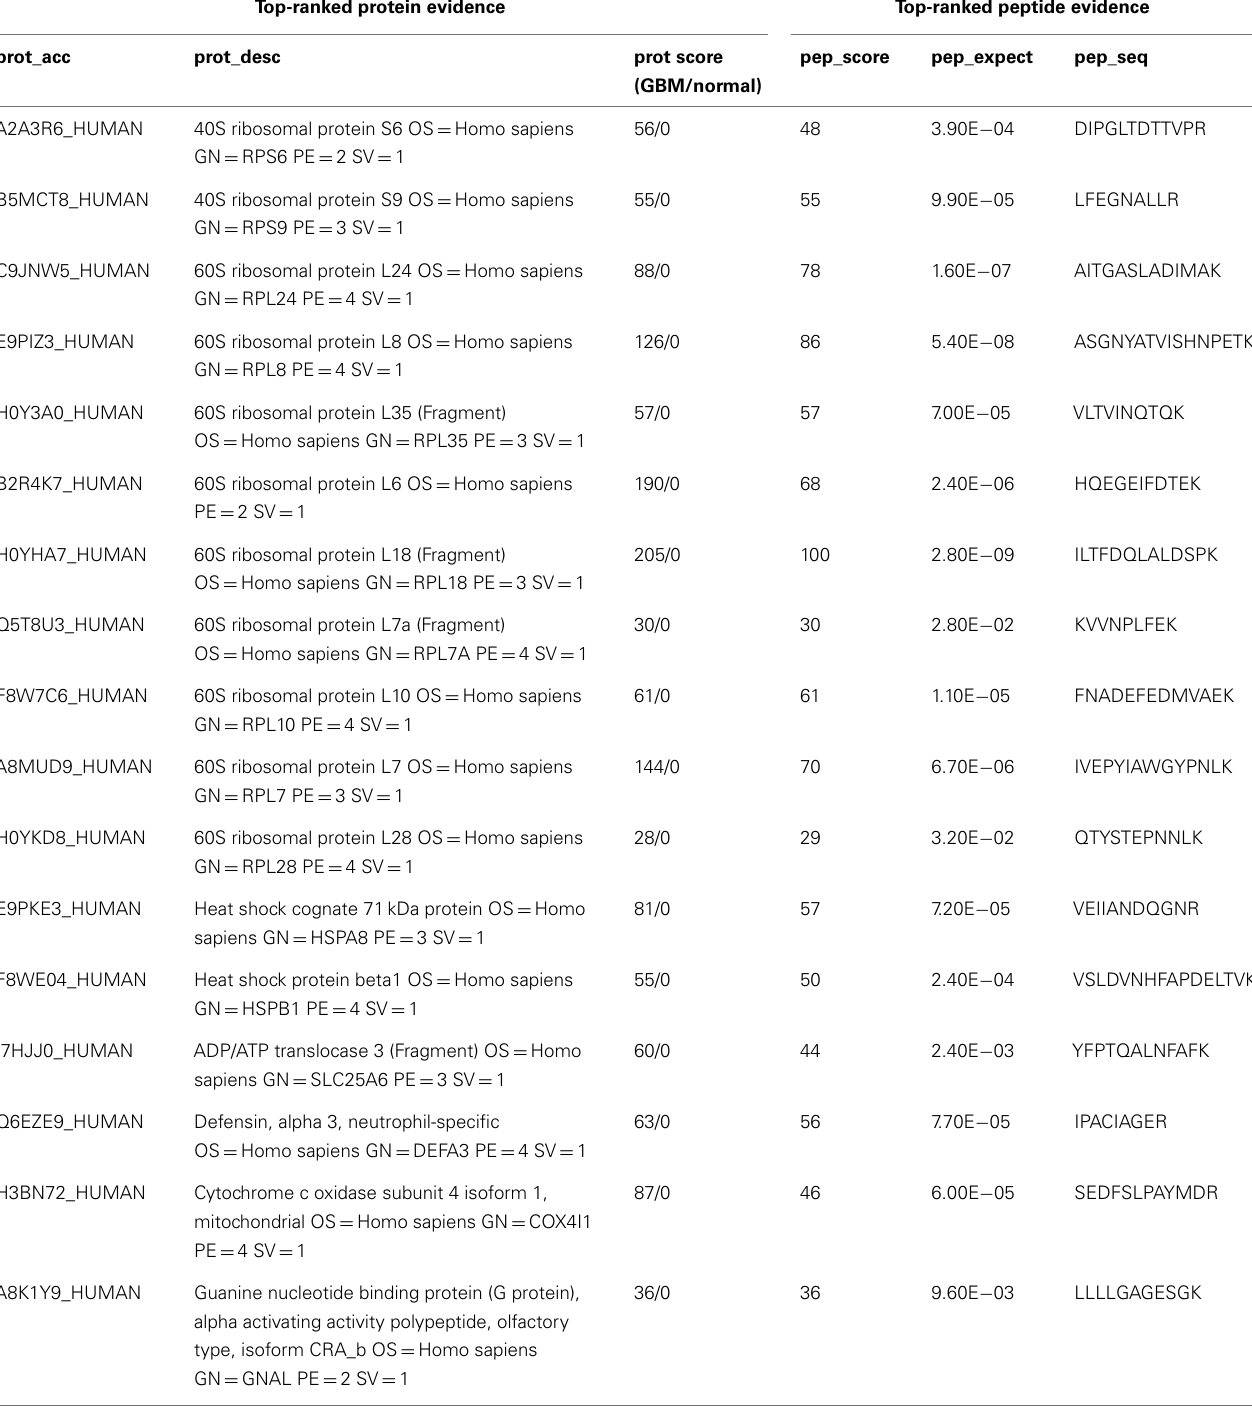
Table 1 | Summary of selected highly expressed proteins for GBM1 vs. normal brain region specimens: representative semi-quantitative data for top-ranked proteins and their top-ranked peptides includes: theTrembl protein database accession symbol (prot_acc), protein description (prot_desc), probability-based protein database searching score (prot_score) for GBM/normal, peptide score (pep_score), peptide expectation value (pep_expect), and peptide sequence